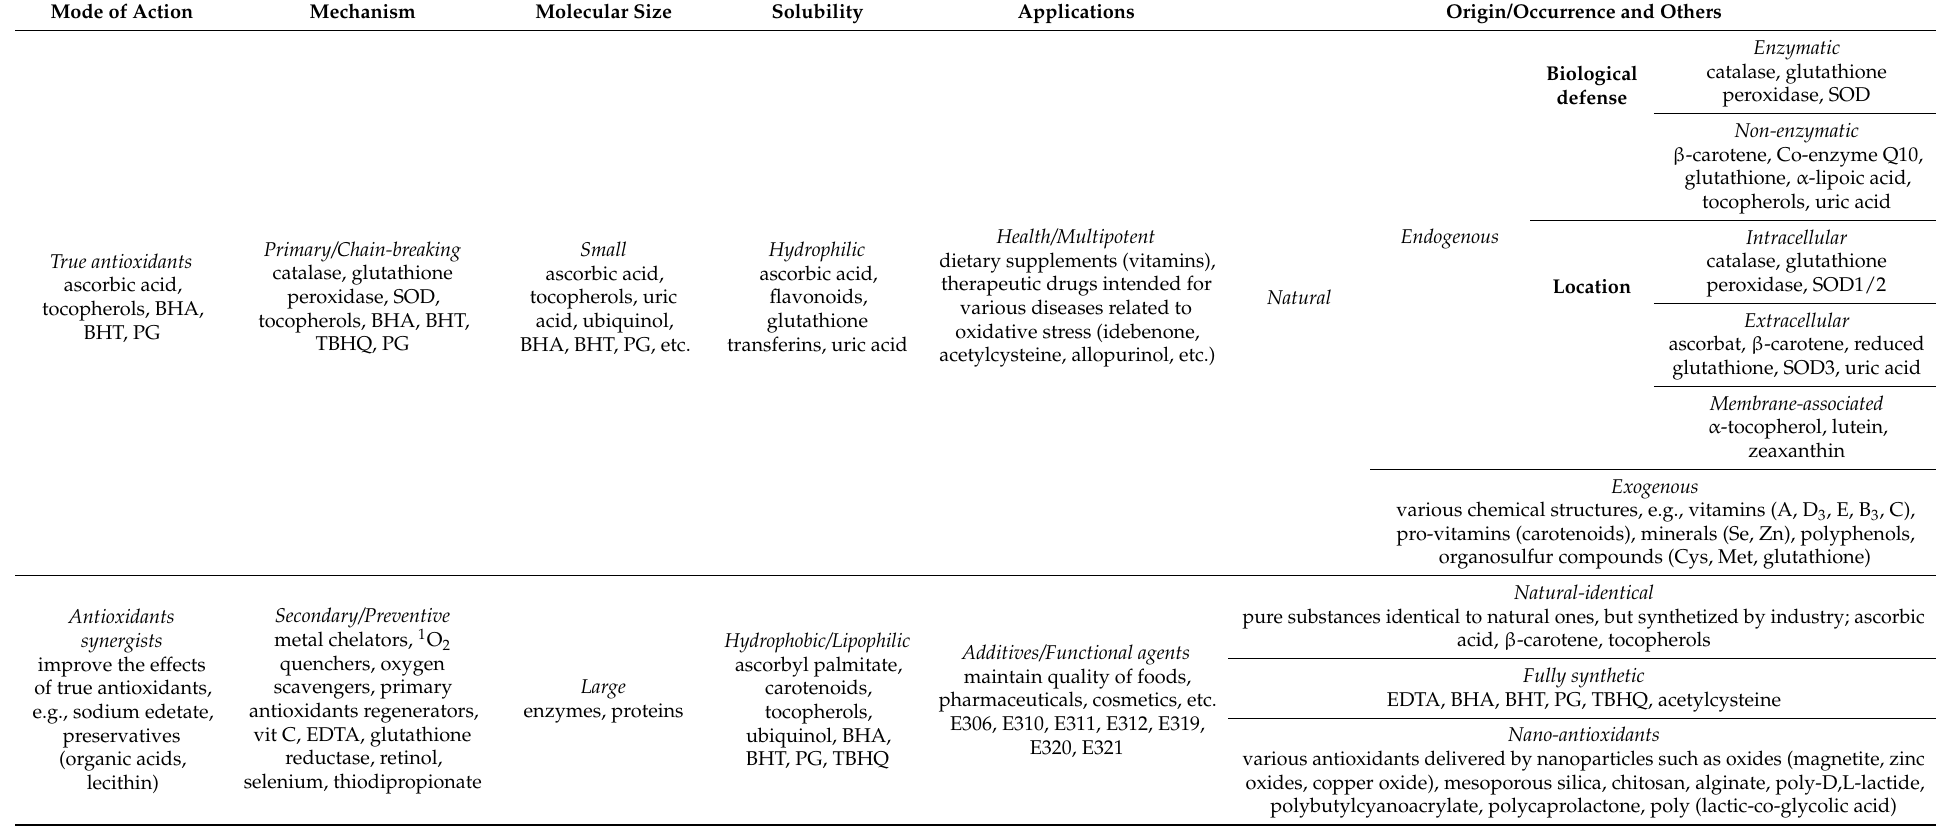
Table 1. Complete classification of antioxidant molecules according to mechanistic, physical-chemical, biological and application